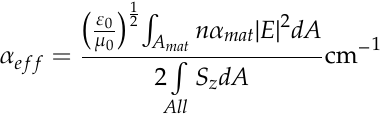
Figure 8. Birefringence of the proposed fiber as a function of core length at f = 2.8 THz for different adulteration of petrol oil with kerosene.